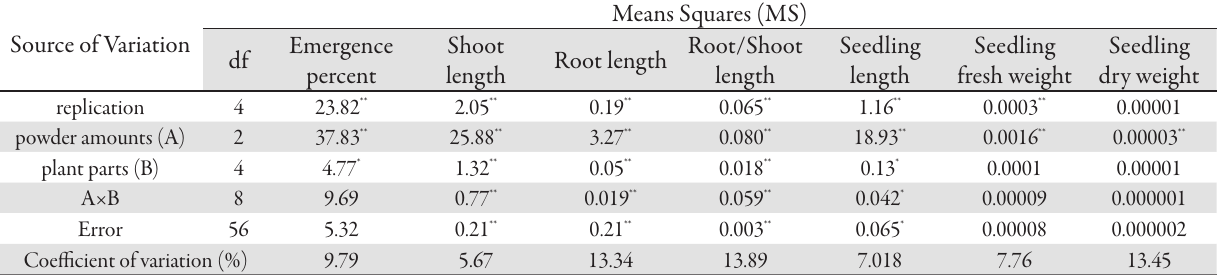
Tab. 1. Analysis of variance of different amounts and plant parts of Russian knapweed ( Acroptilon repens L.) on the seedling emergence and growth of Amaranthus retroflexus L Source of Variation